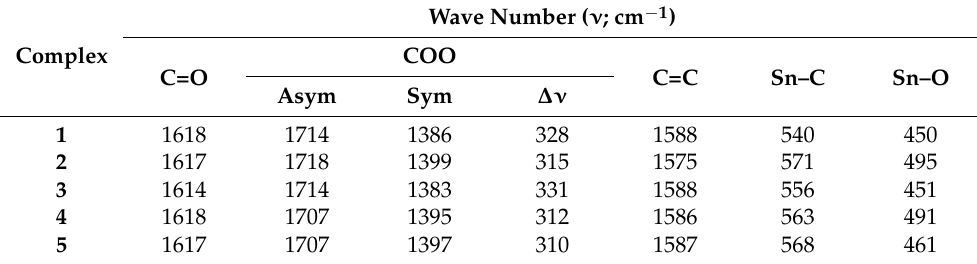
Table 2. The FTIR absorption bands for complexes 1 – 5 .